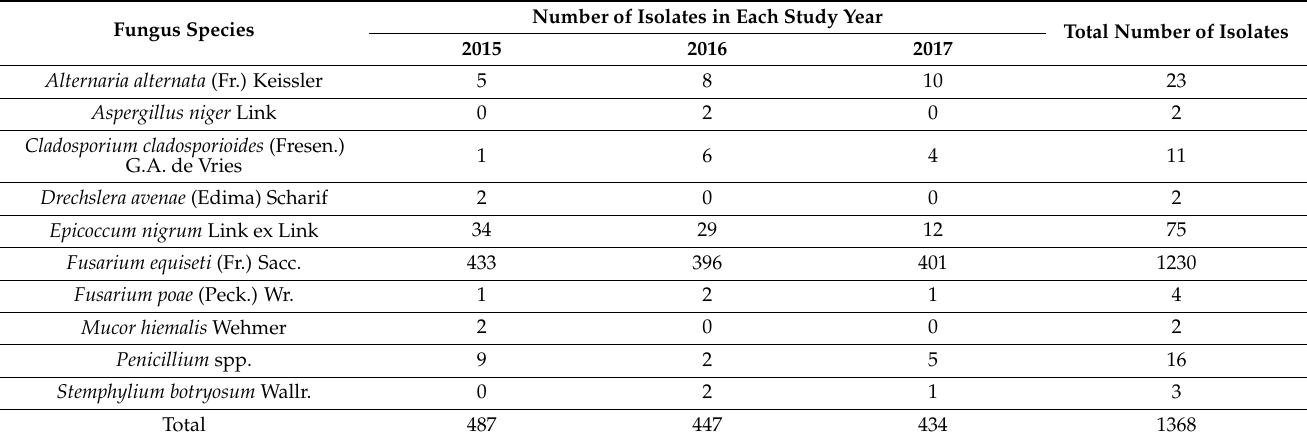
Table 3. Fungi isolated from kernels obtained from panicles inoculated with F. equiseti in 2015–2017.